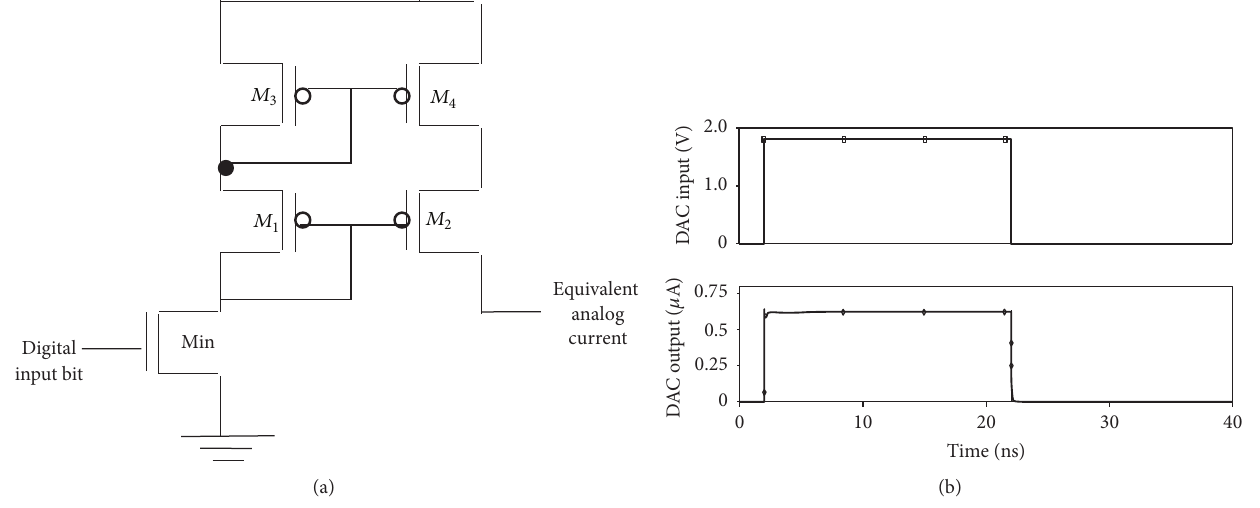
Figure 14: (a) 1-bit DAC and (b) output